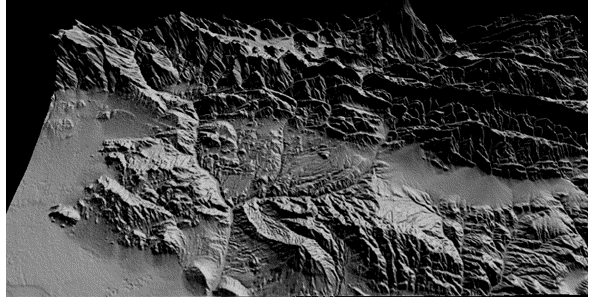
Figure 4. A view of the shaded relief of the Roodehen, generated from the SRTM